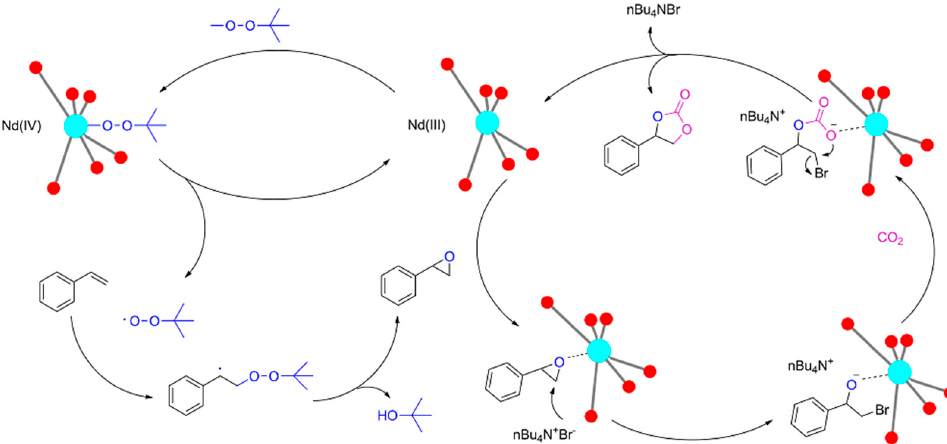
Scheme 13. The schematic representation of tandem catalysis for the asymmetric cyclic carbonate transformation fromolefins and carbon